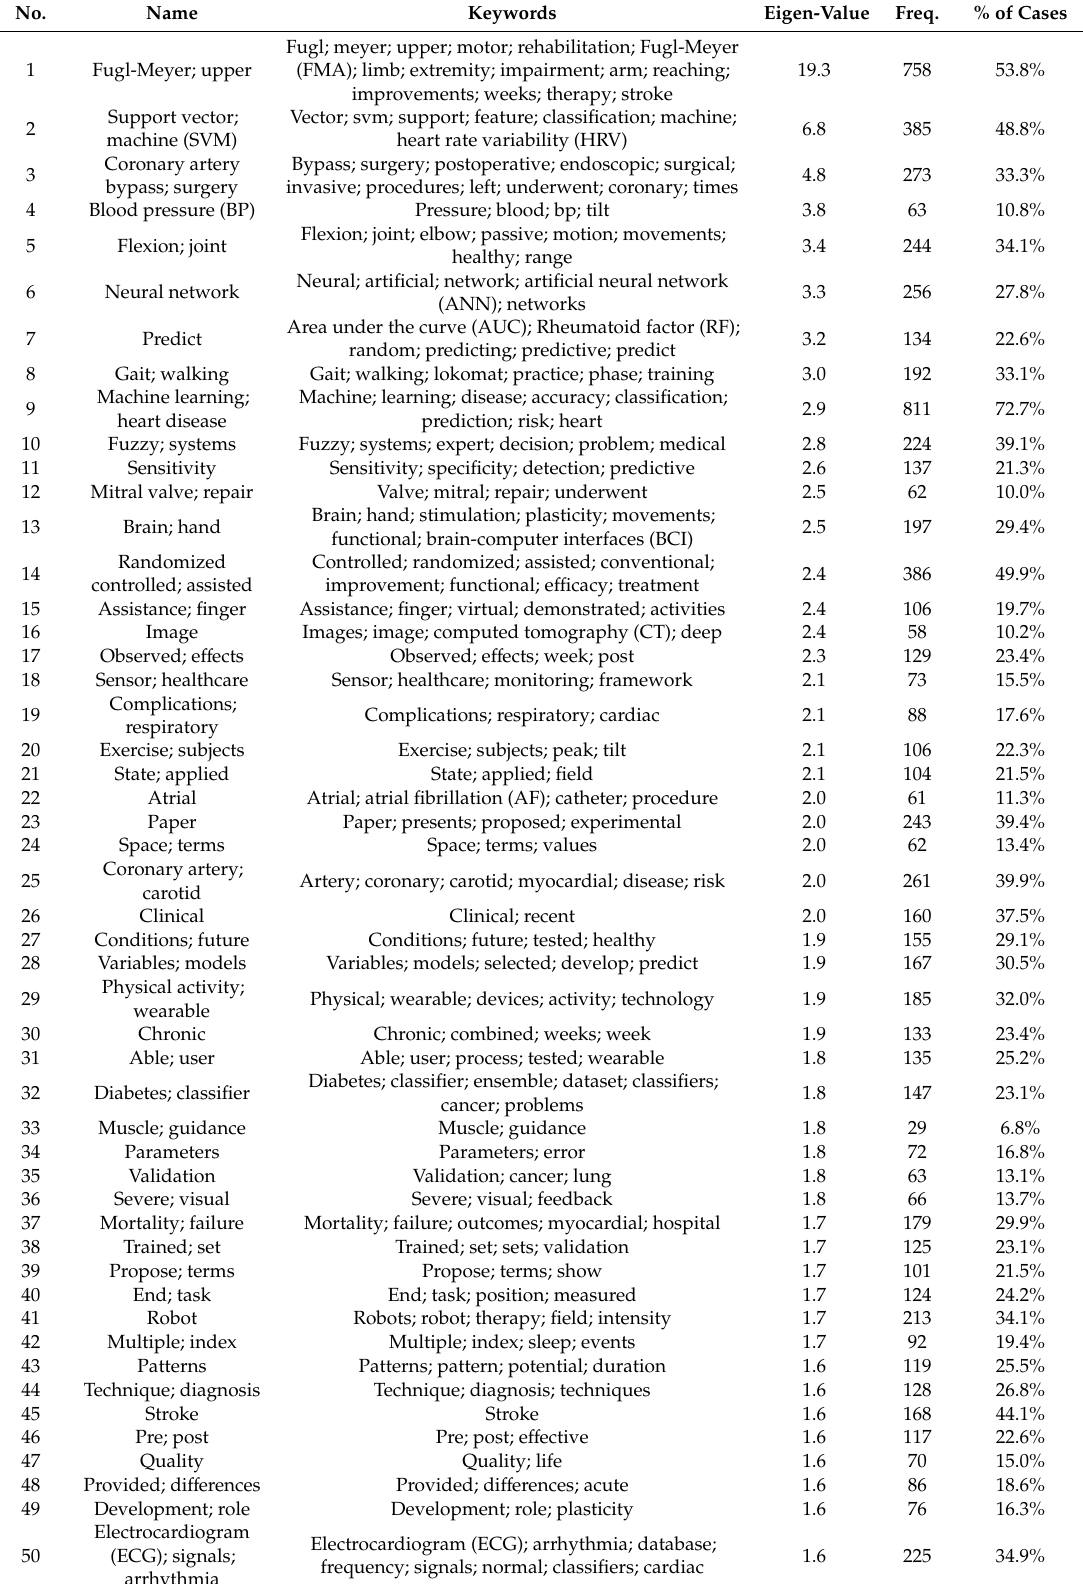
Table4. Top50researchdomainsthatemergedfromtheexploratoryfactoranalysisofallabstractcontent.